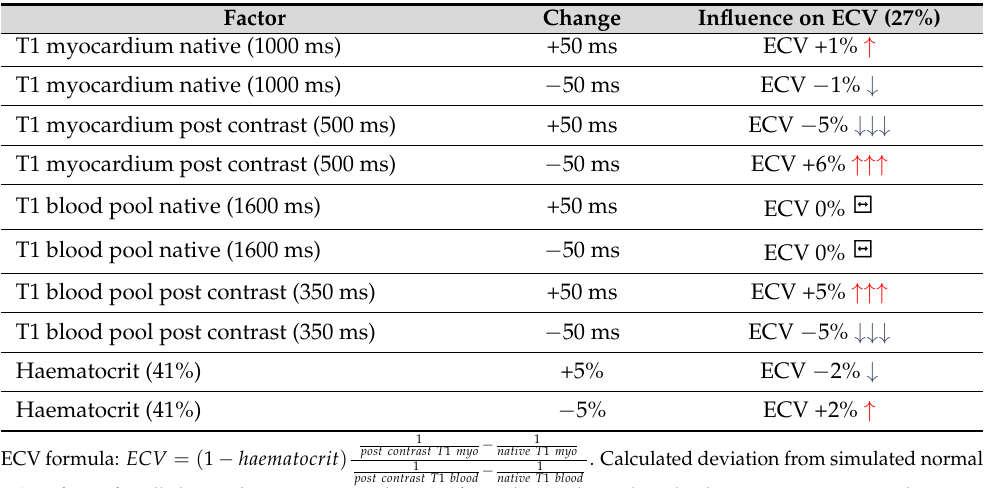
Table 2. Influencing calculational factors in ECV formula.